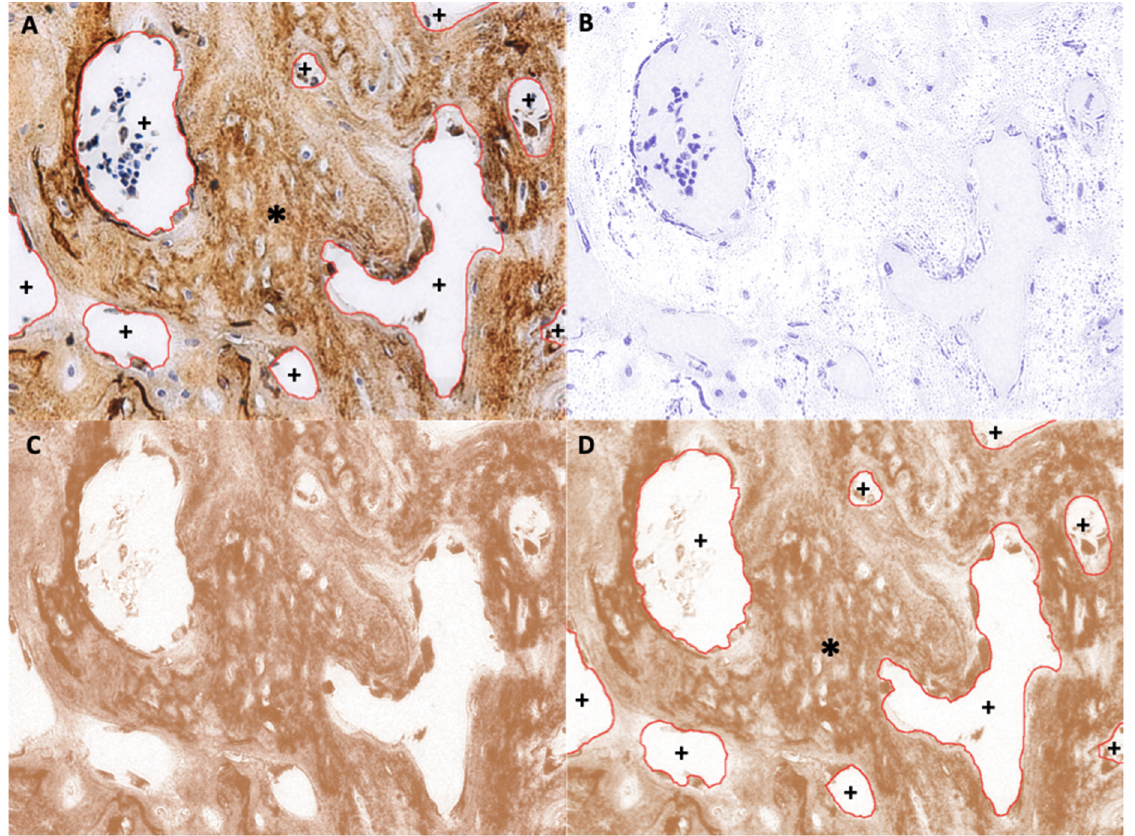
Figure 6. Example of new bone area ROI selection (anti-OCN IHC staining). ( A ) Original image with overlay of the selected ROI, which is the area of new bone. *, selected area; +, unselected area. ( B ) Hematoxylin-stained image separated from the original image. ( C ) DAB-stained image separated from the original image. ( D ) Superimposition of the saved ROI onto the DAB-stained image. *, selected area; +, unselected area.